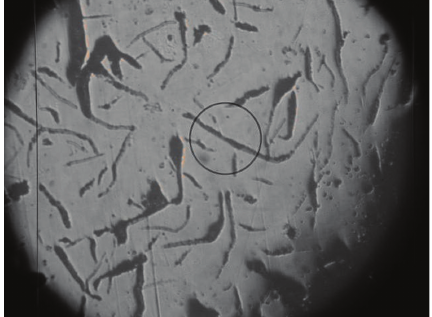
Figure 8: Microstructure in zone A 100x.